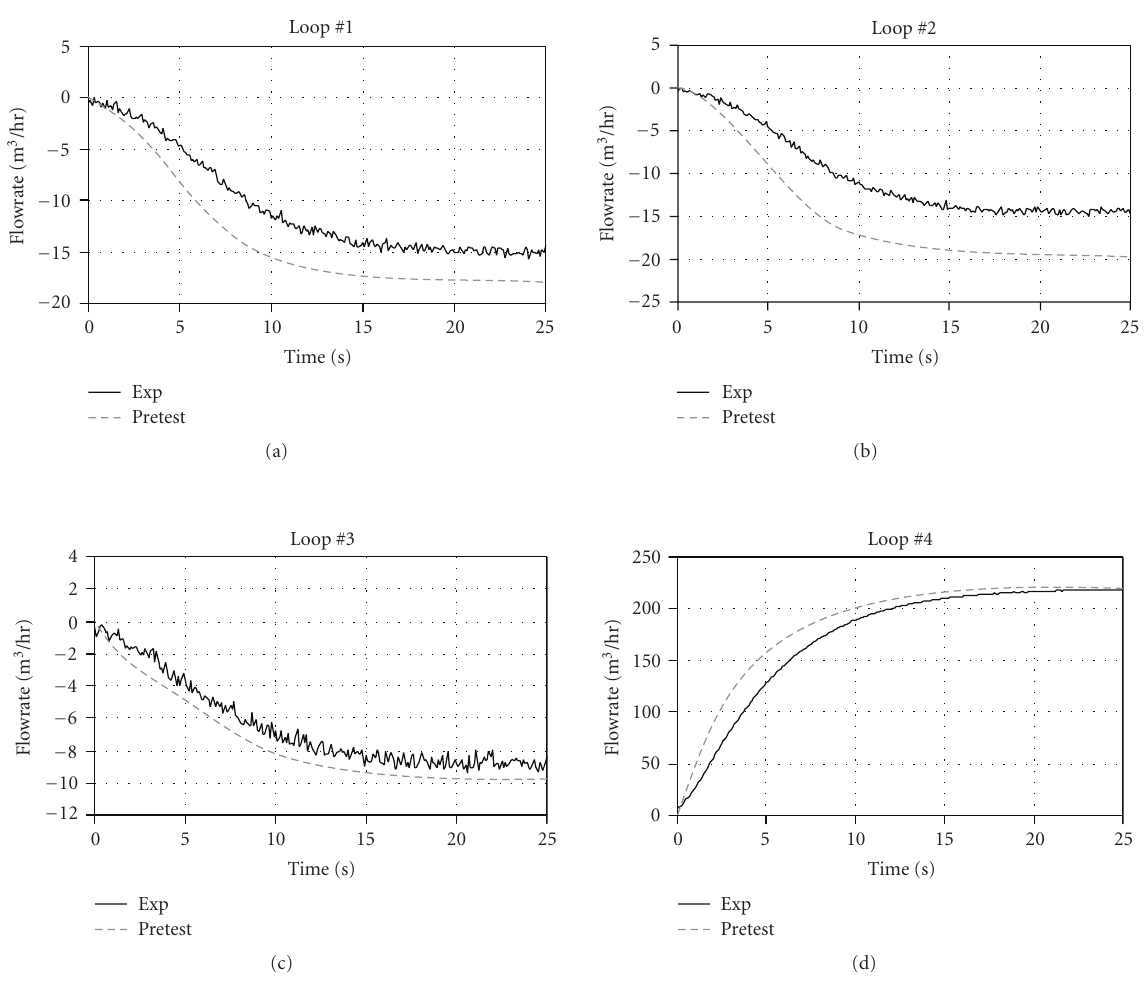
Figure 5: Loop flowrates (posttest values coincide with experimental values).